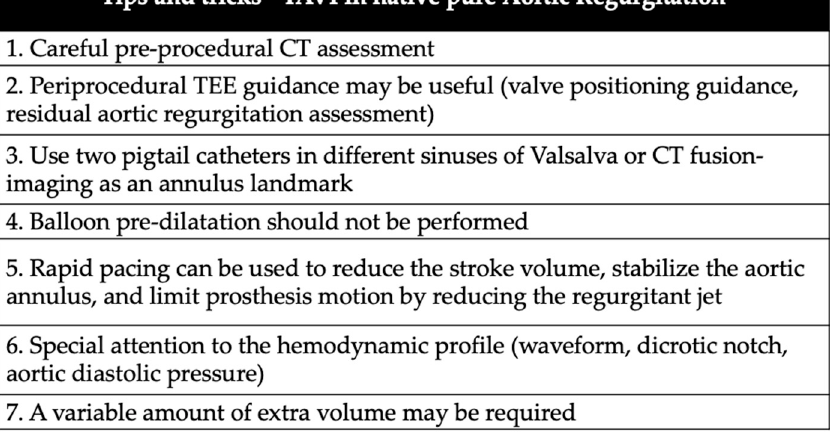
Figure 7. Tips and tricks to perform a TAVI in PNAR.